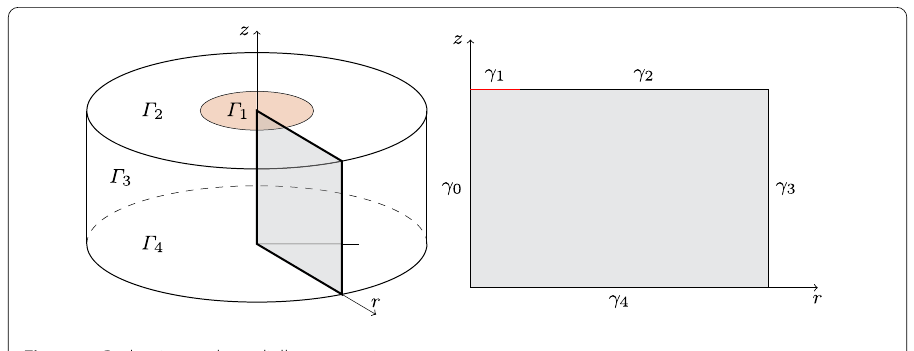
Figure 4 Reduction to the radially symmetric